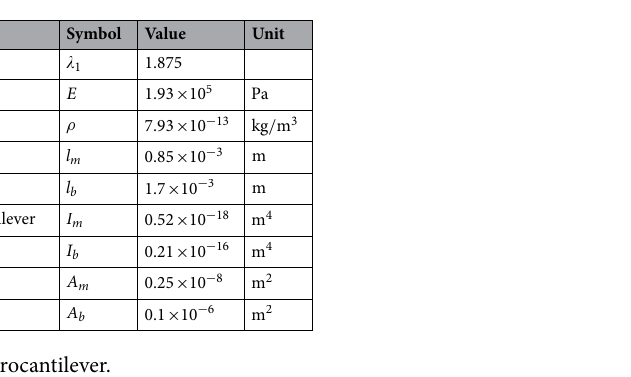
Table 1. Parameters of the